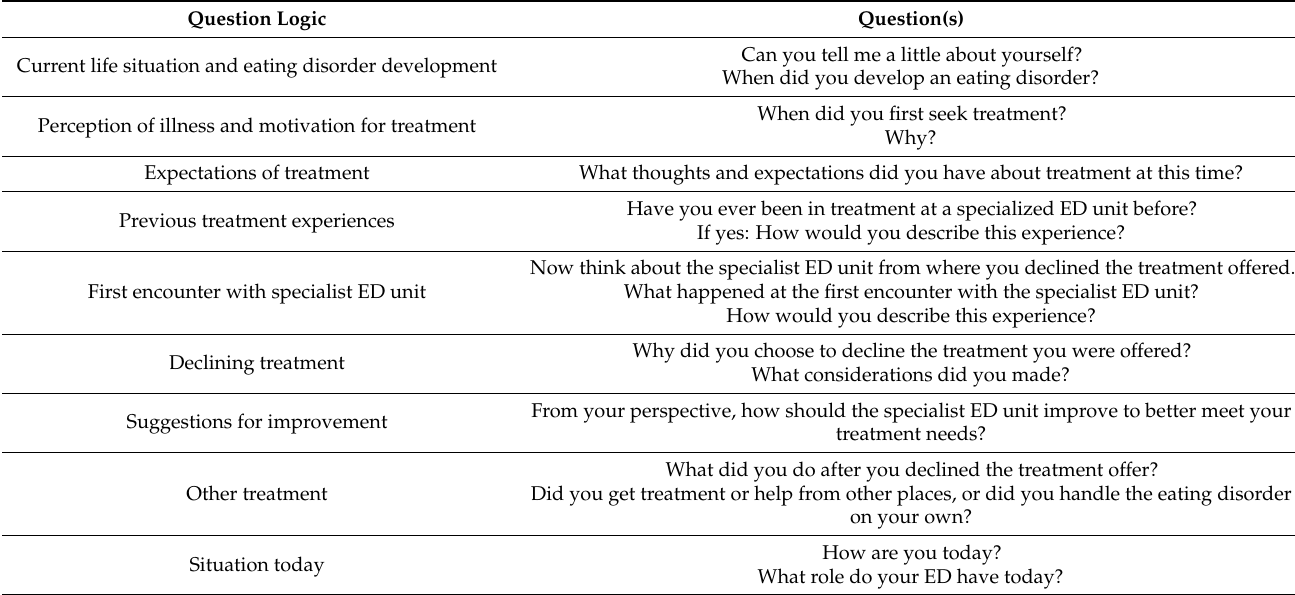
Table 2. Interview